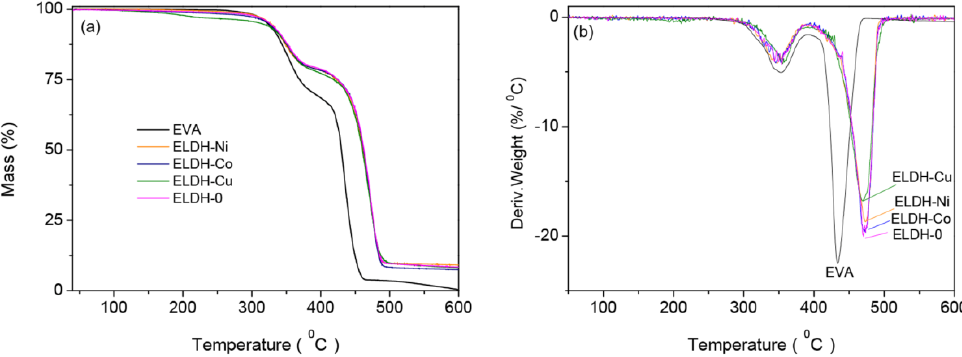
Figure 4. TGA-DTG curves of EVA and composites, ( a ) TGA curves; and ( b ) DTG curves.